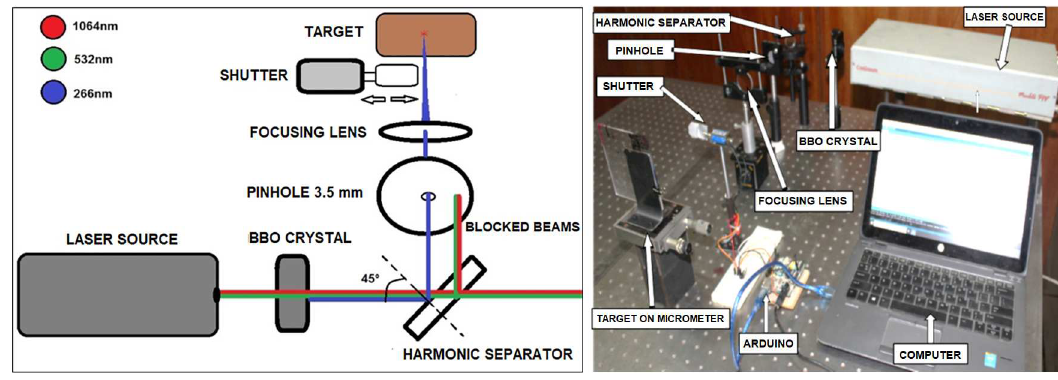
Fig 1. (a) Schematic diagram and (b) lab photo of the implemented setup.